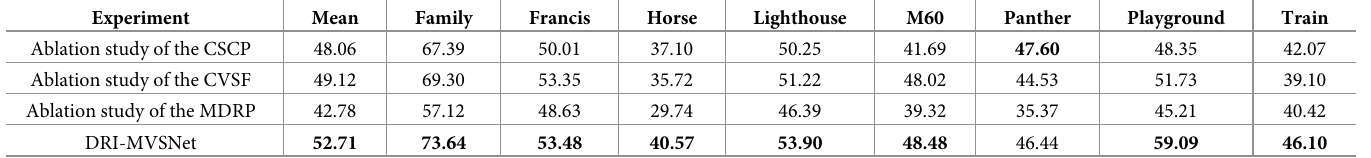
Table 5. Ablation study of the CSCP, the CVSF and the MDRP on the Tanks & Temples dataset.